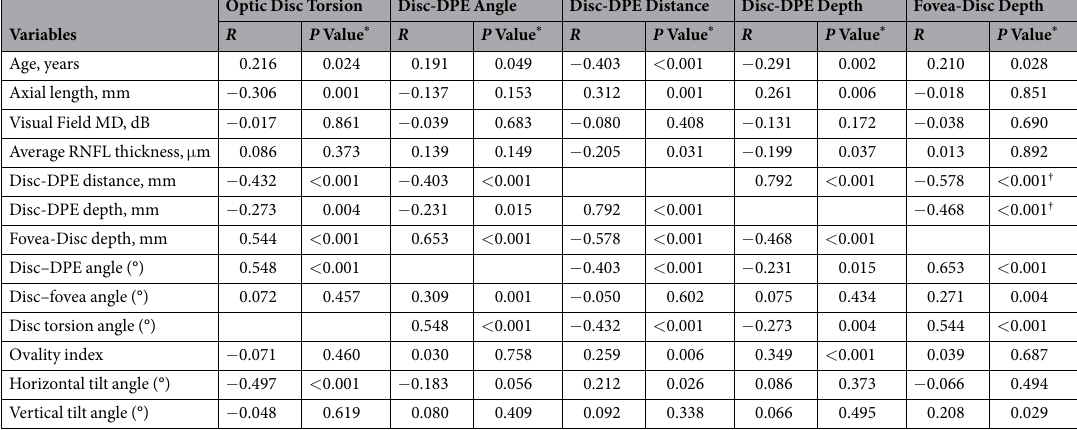
Table 3. The correlation analysis on the posterior pole configuration and the optic nerve head. * Pearson’s correlation